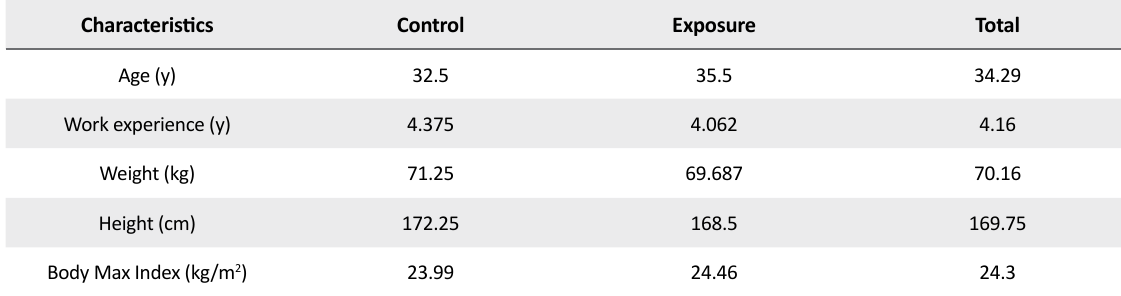
Table 5. Characteristics of the study participants Characteristics